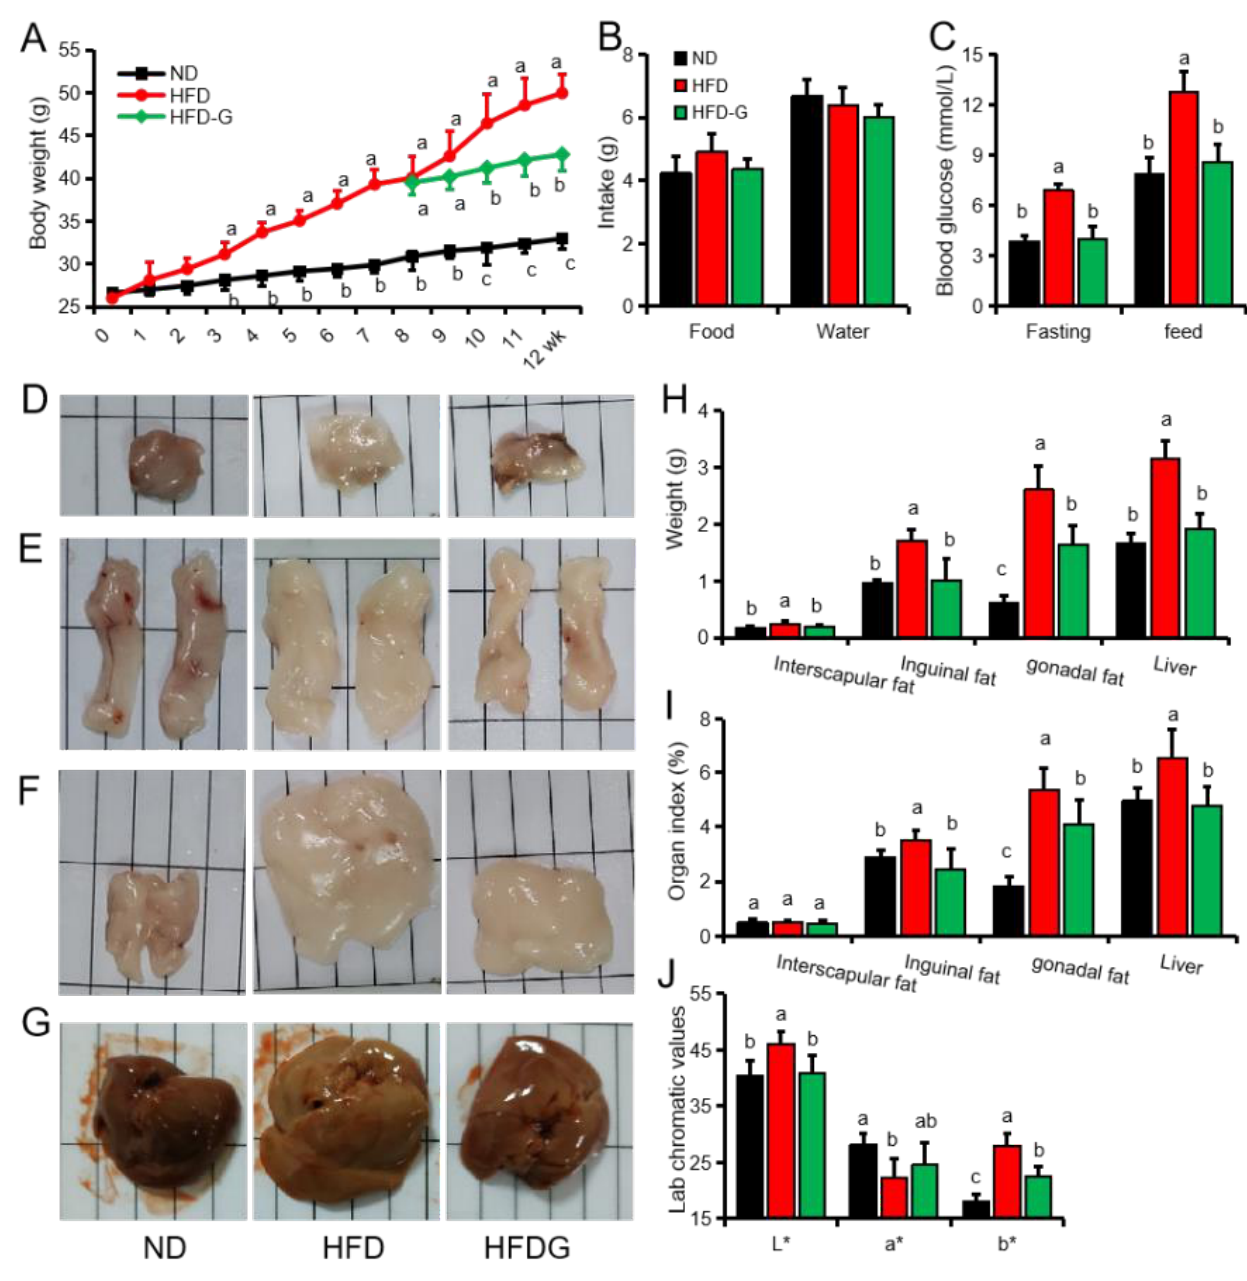
Figure 1. Genistein inhibits high-fat diet (HFD)-induced obesity in mice. ( A ) Weekly body weight of mice. ND: normal maintenance diet, HFDG: HFD diet supplemented with genistein. ( B ) Mean daily food and water intake. ( C ) Feed or fasting (8 h) blood glucose. ( D – G ) Images of the